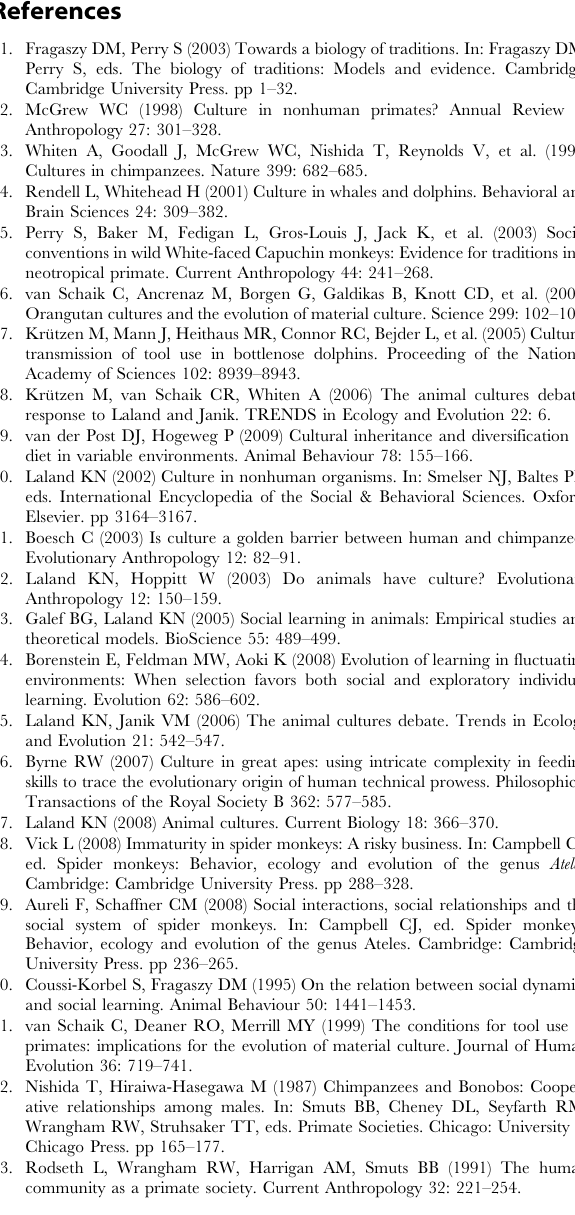
Table S1 Definitions and domains of the 62 behaviors considered in the study. Table S2 Prevalence of behavior variants across study sites. Table S3 Distance (kilometers) between sites (using Google Earth ruler, http://earth.google.com ). Table S4 Site